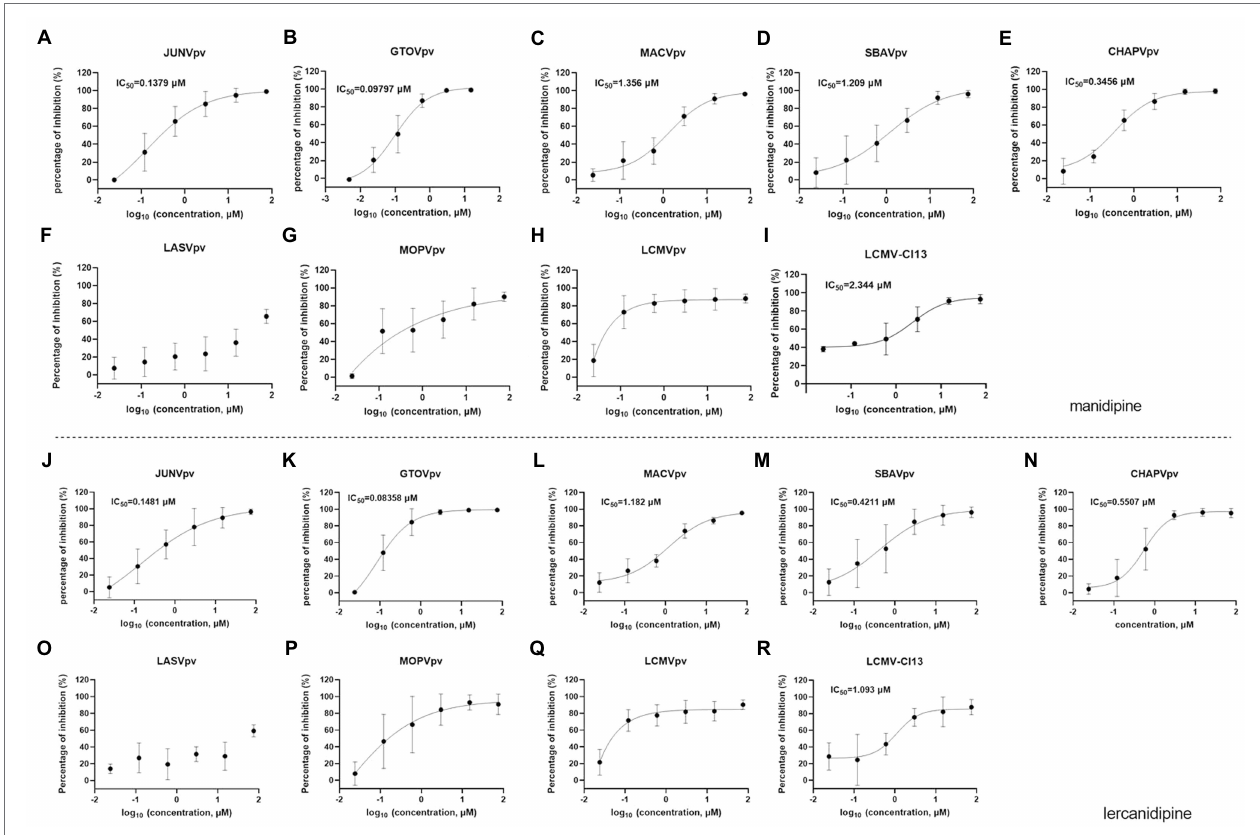
FIGURE 7 | Broad-spectrum antiviral activities of manidipine and lercanidipine. (A–H) Effects of manidipine on the infection of the pseudotype of mammarenaviruses. (I) Inhibition of manidipine against authentic LCMV infection. (J–Q) Effects of lercanidipine on the infection of the pseudotypes of mammarenaviruses. (R) Inhibition of lercanidipine against authentic LCMV infection. Data are presented as means ± SD from 3 to 5 independent